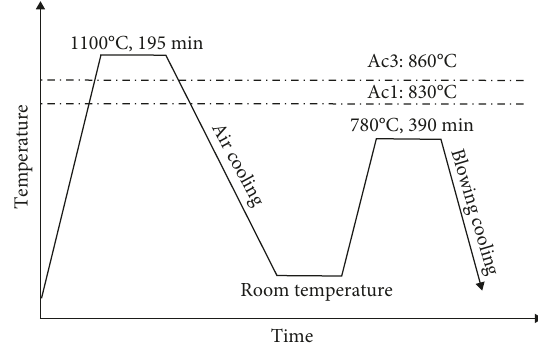
Figure 1: The schematic diagram of heat treatment processing of G115